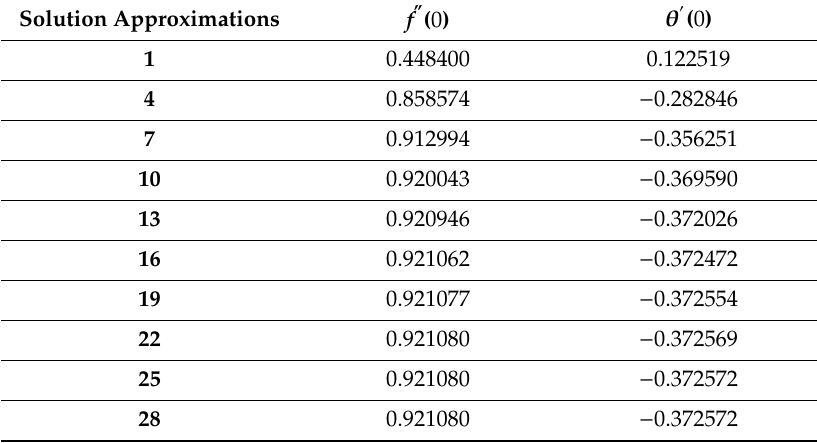
Table 1. Fast convergence of HAM (homotropy analysis method).